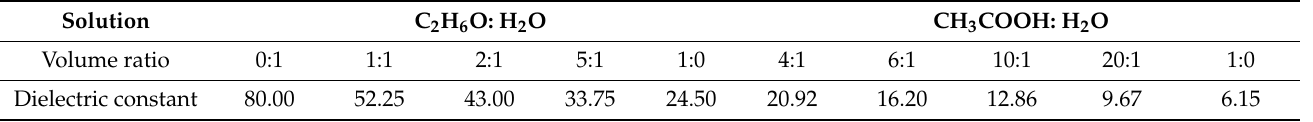
Table 3. Dielectric constants of organic